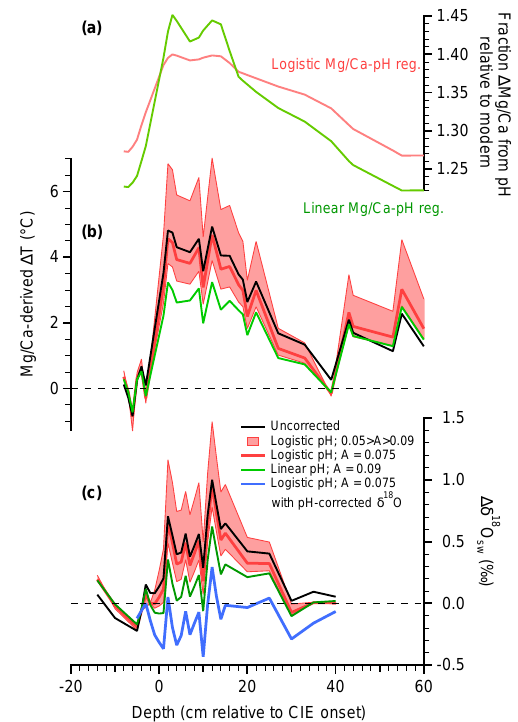
Figure 6. Panel (a) : the fraction shift in Mg / Ca over the PETM based on the calibrations between Mg / Ca and pH shown in Fig. 1, and the pH reconstructions of Penman et al. (2014, assuming initial pH = 7.8). All data are shown relative to Mg / Ca at modern pH and display the relative change as a result of pH only. Panel (b) : ODP Site 1209 Morozovella Mg / Ca-derived temperature shift across the PETM. The data are shown as originally reported and with various corrections for both pH and Mg / Ca sw , relative to the pre-carbon isotope excursion (CIE) baseline. Panel (c) : δ 18 O sw shift from cou- pled Mg / Ca– δ 18 O data, based on the range of transient tempera- ture shifts shown in (b) . Our preferred record (blue line), corrected for the pH effect on both foraminifera Mg / Ca and δ 18 O, and ac- counting for the likely lower sensitivity of Mg / Ca to temperature in PETM seawater, implies little change in subtropical Pacific sur- face hydrology over the event. Data from Penman et al. (2014) and Zachos et al.